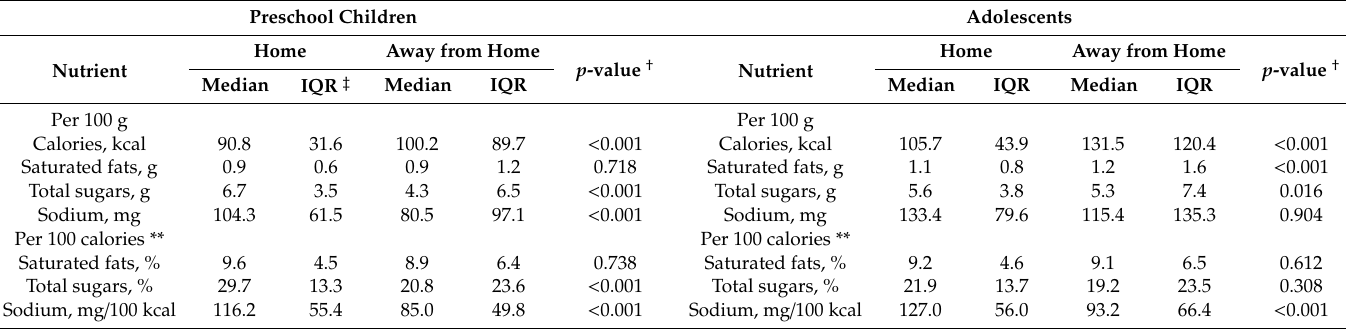
Table 2. Nutrient density per 100 g and per 100 calories by food source * among low- and middle-income Chilean preschool children and adolescents from Southeast Santiago, 2016. Preschool Children